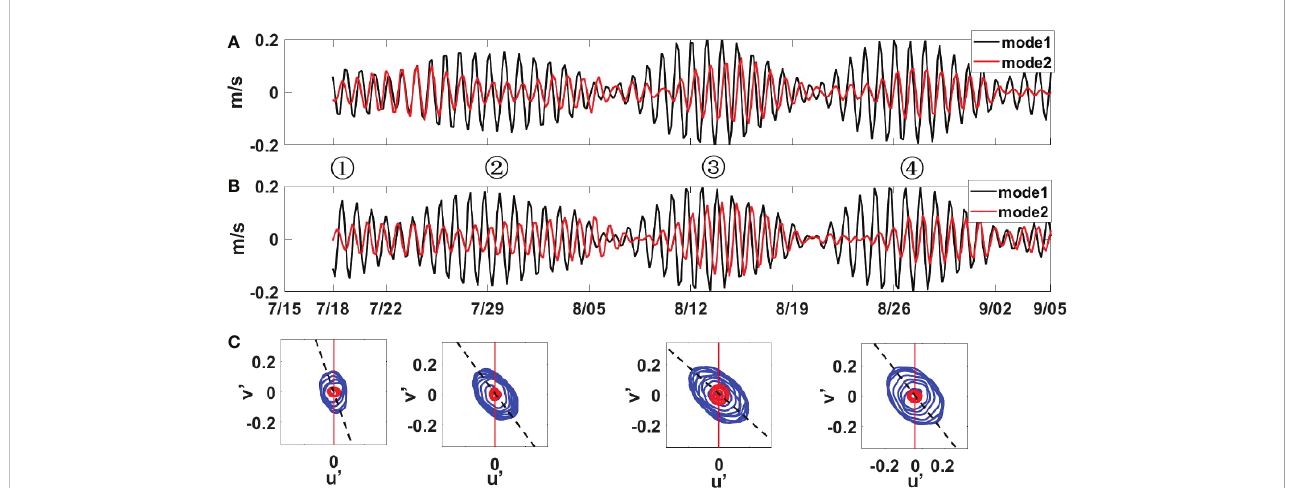
FIGURE 5 (A) Time series of mode-1(black) and mode-2 (red) diurnal along-slope velocities ( u ′ ). (B) Time series of mode-1(black) and mode-2 (red) diurnal cross- slope velocities ( v ′ ). (C) The diurnal u ′ v ′ hodographs of mode-1 (blue) and mode-2 (red) components at each spring period. The red lines represent the cross-slope direction. Black dashed lines are the along-beam direction of mode-1 internal tides.